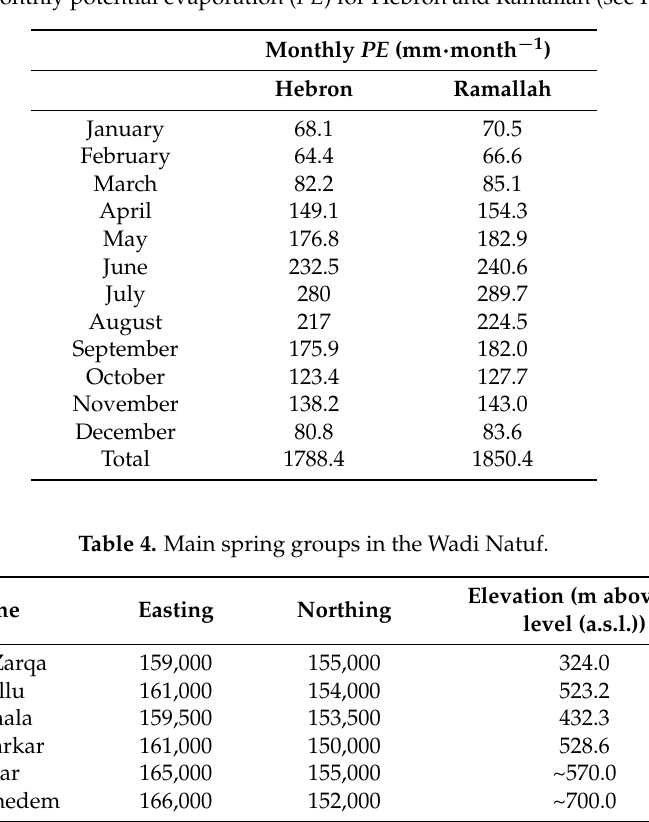
Table 3. Monthly potential evaporation ( PE ) for Hebron and Ramallah (see Figure 1).